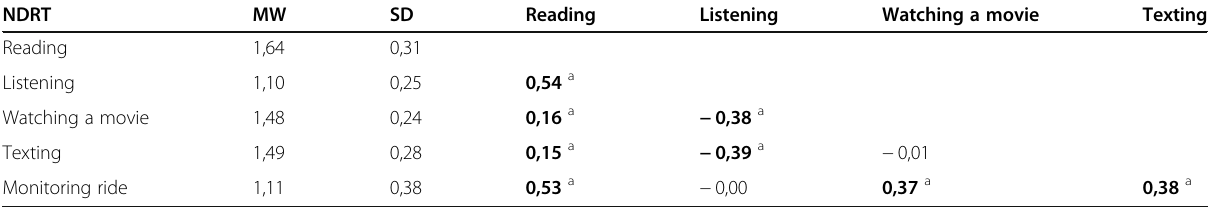
Table 4 Overview of the results minimal Take-over time in s NDRT MW